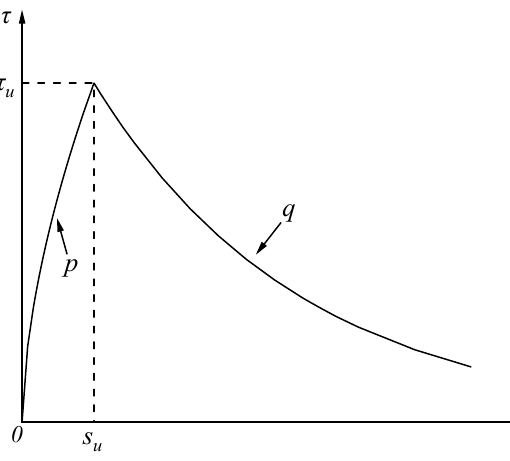
Figure 7. Bond–slip constitutive relation.